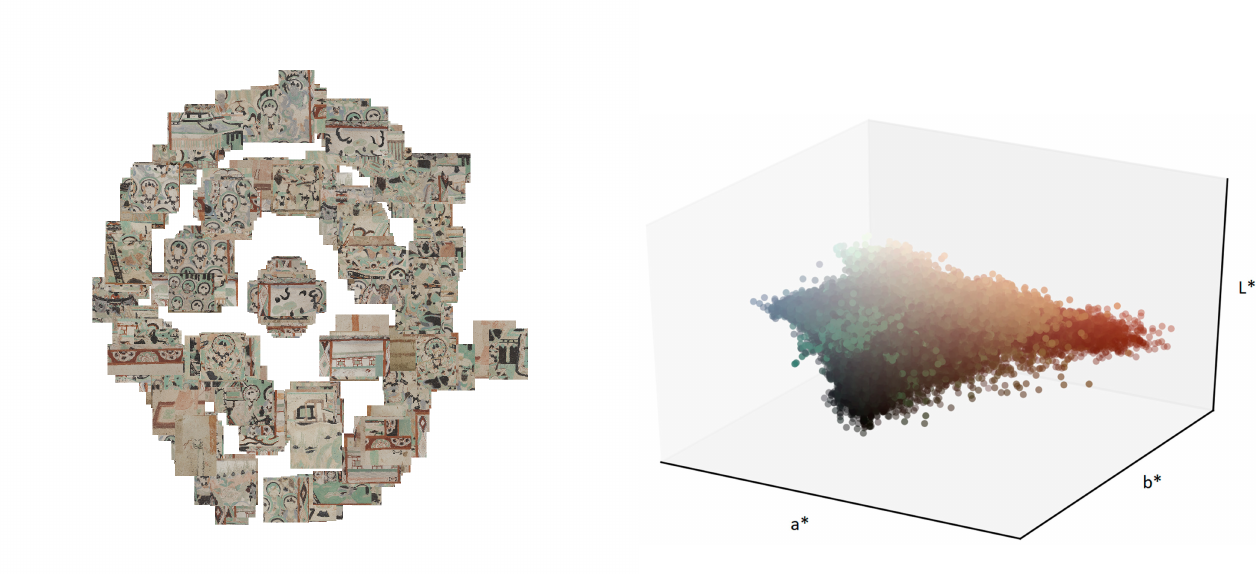
Figure 1. Left : Dunhuang dataset visualized in a two dimensional space with Barnes-Hut Stochastic Neighbour Embedding (BH-SNE) [8]. The clustering is done based on the activations of the first fully connected layer of the pretrained VGG19 network [9] that outputs a vector of 4096 features (color, size, semantics, etc.) for each image. Images are displayed exactly at their embedded location in the two-dimensional (2D) projection space. Right : color gamut of the Dunhuang dataset. The L*a*b* coordinates are rendered with the corresponding RGB